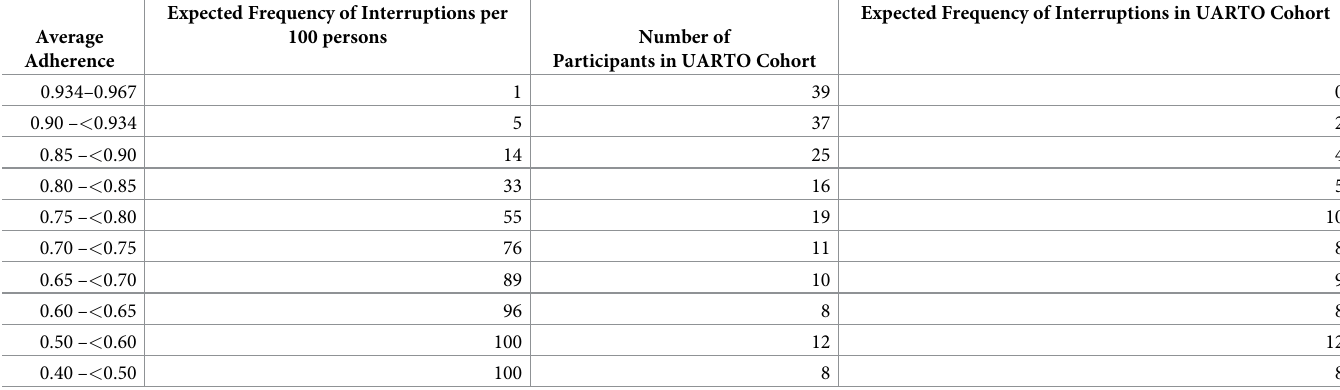
Table 1. Expected number of persons with at least one ART interruption of three days or more by average adherence. Average